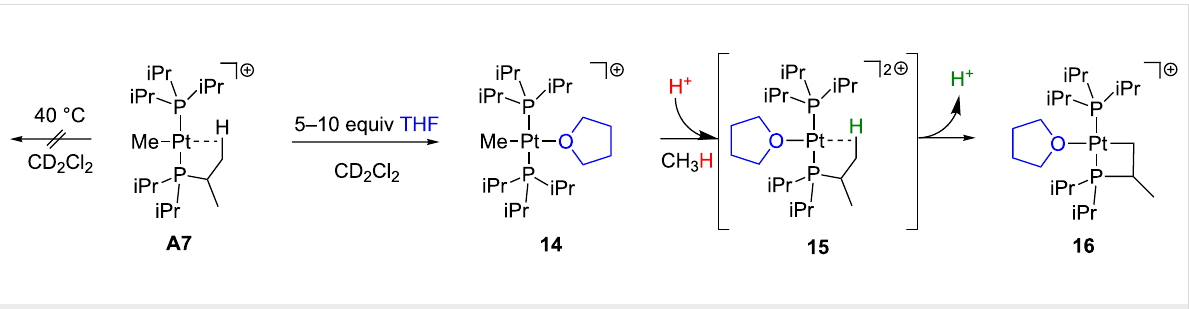
Scheme 13: Proposed mechanism for the acid-catalyzed cyclometalation of 14 via intermediate 15